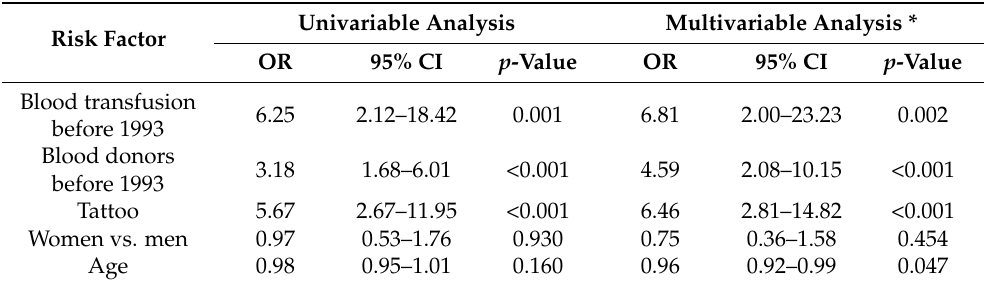
Table 4. Odds ratios (95% CI) of seropositivity of hepatitis C virus infection by possible risk factors (logistic regression analysis). Univariable Analysis Multivariable Analysis Risk Factor